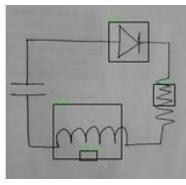
Fig. 5: Inductor detected as Resistor and Voltage